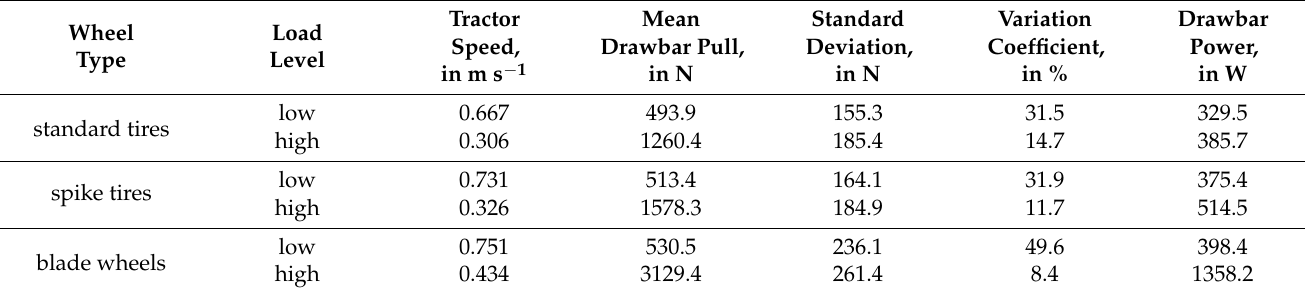
Table 3. Drawbar parameters of the tractor with different driving wheels with low and high loads.